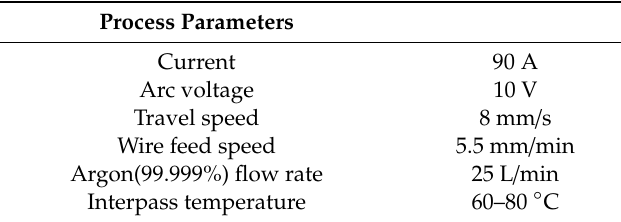
Table 2. Process parameters for the Al-Mg and Al-Mg-0.3Sc alloys.